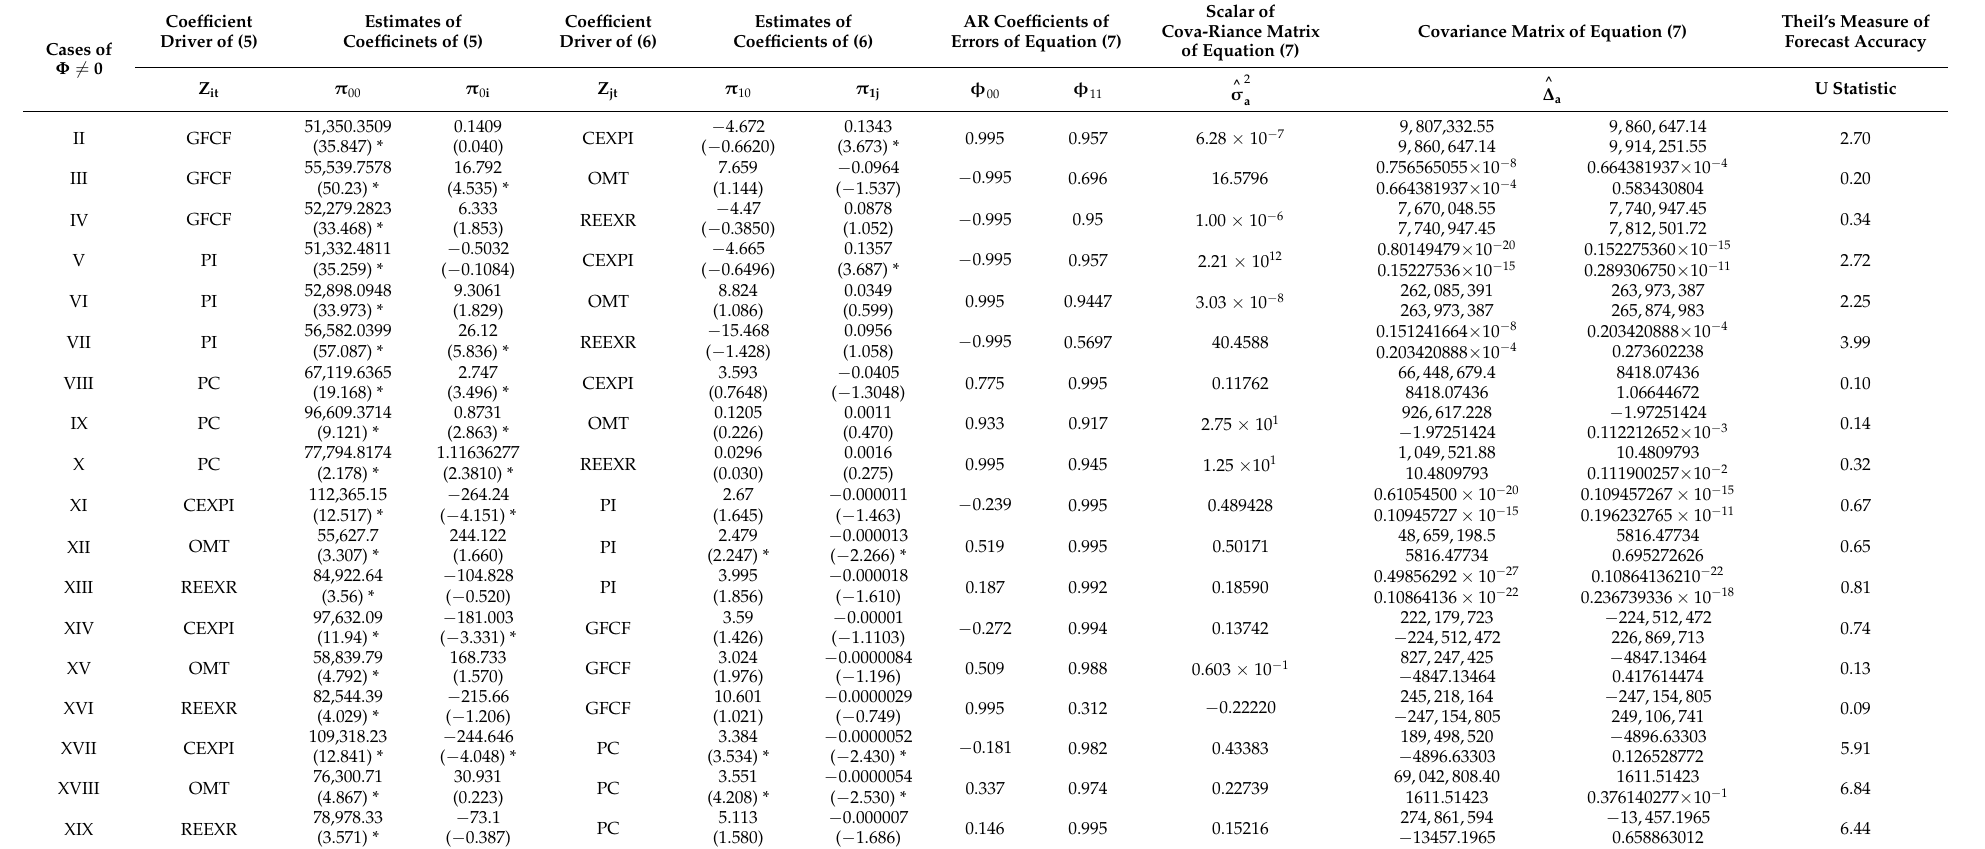
Table 2. Estimates of the Coefficients of Equations (5) and (6) and the Variance–Covariance of Process (7) When the Diagonal Parameter Matrix of Process (7) is NOT Restricted to be